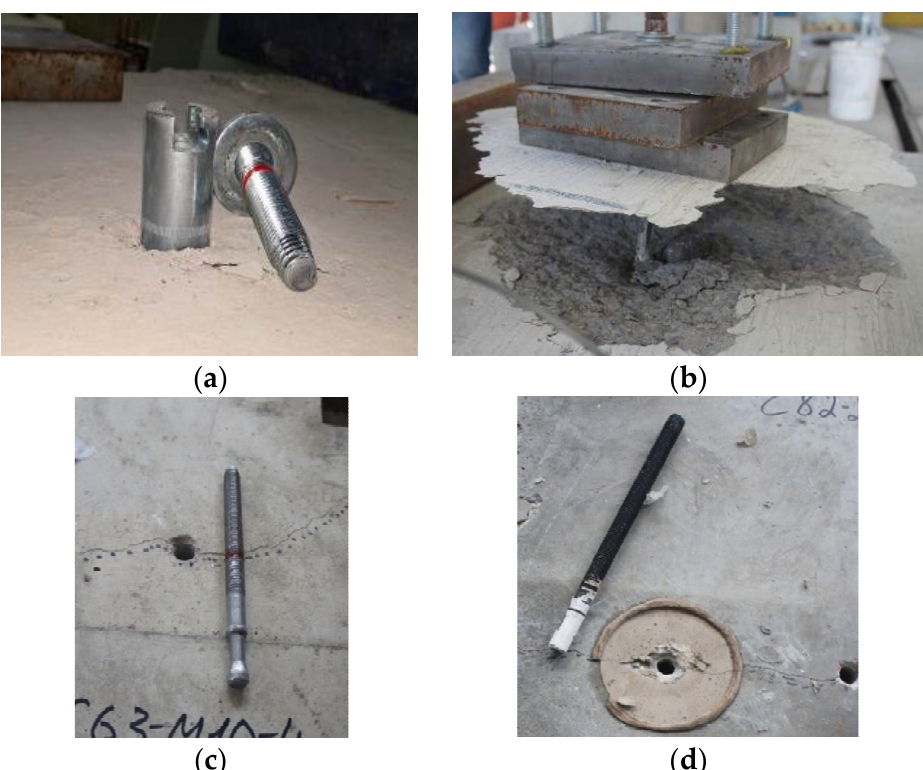
Figure 8. Failure mechanisms of anchors embedded in a concrete base having a crack: ( a ) steel failure (anchor material failure); ( b ) base concrete failure; ( c ) slippage failure; ( d ) failure at the interface between the adhesive composition and the base.